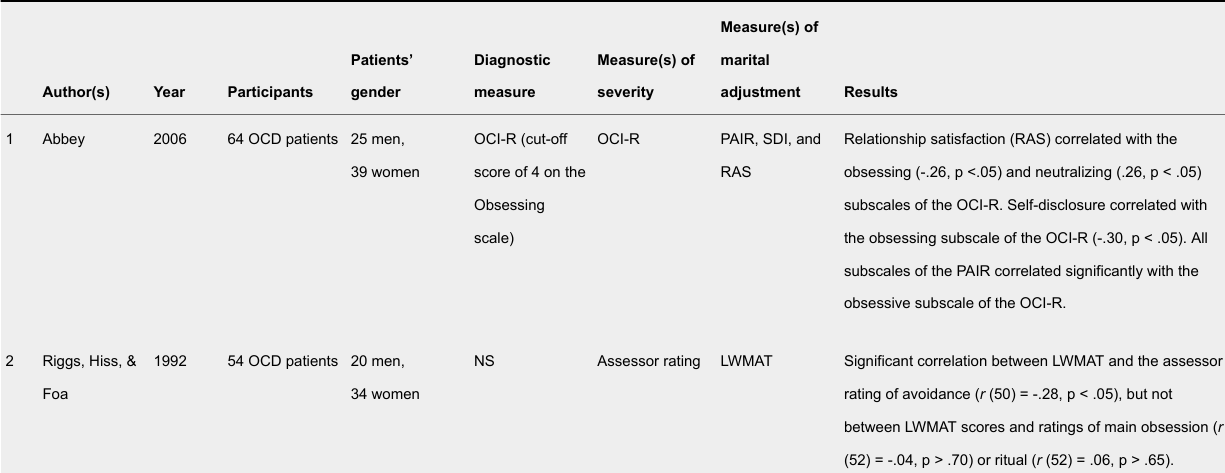
Description of Studies Examining the Association Between Marital Adjustment and OCD